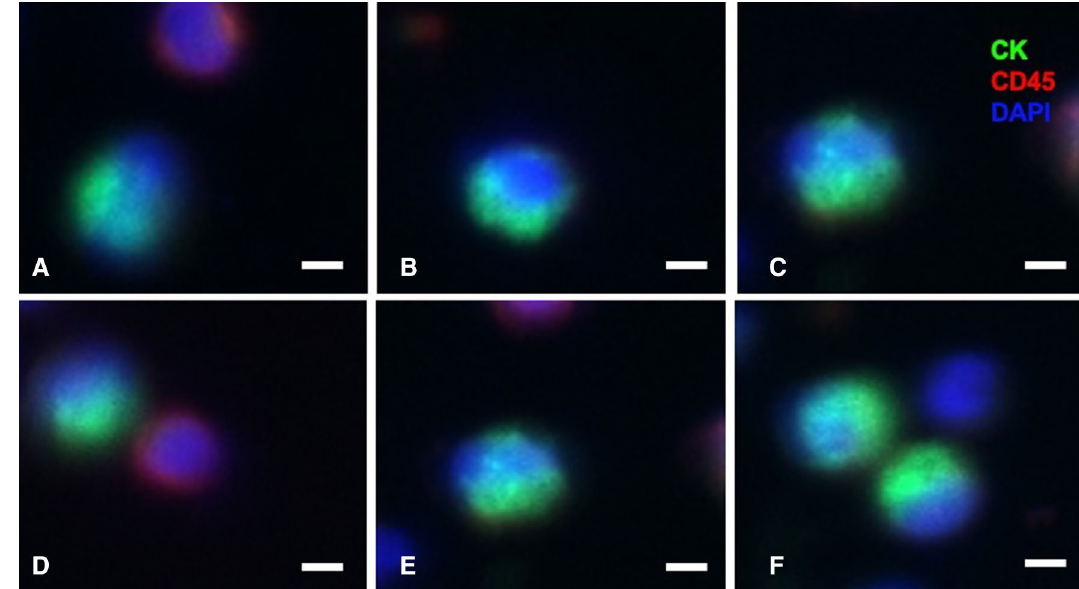
Figure 1. Circulating tumor cells are present in blood samples from patients. ( A – F ) Immunofluorescence staining of representative cells obtained from IsoFlux. Cancer cells fulfilled criteria for CTCs, including: nucleated (blue), CK-positive (green), and CD45-negative cells (non-red). Scale bar, 10